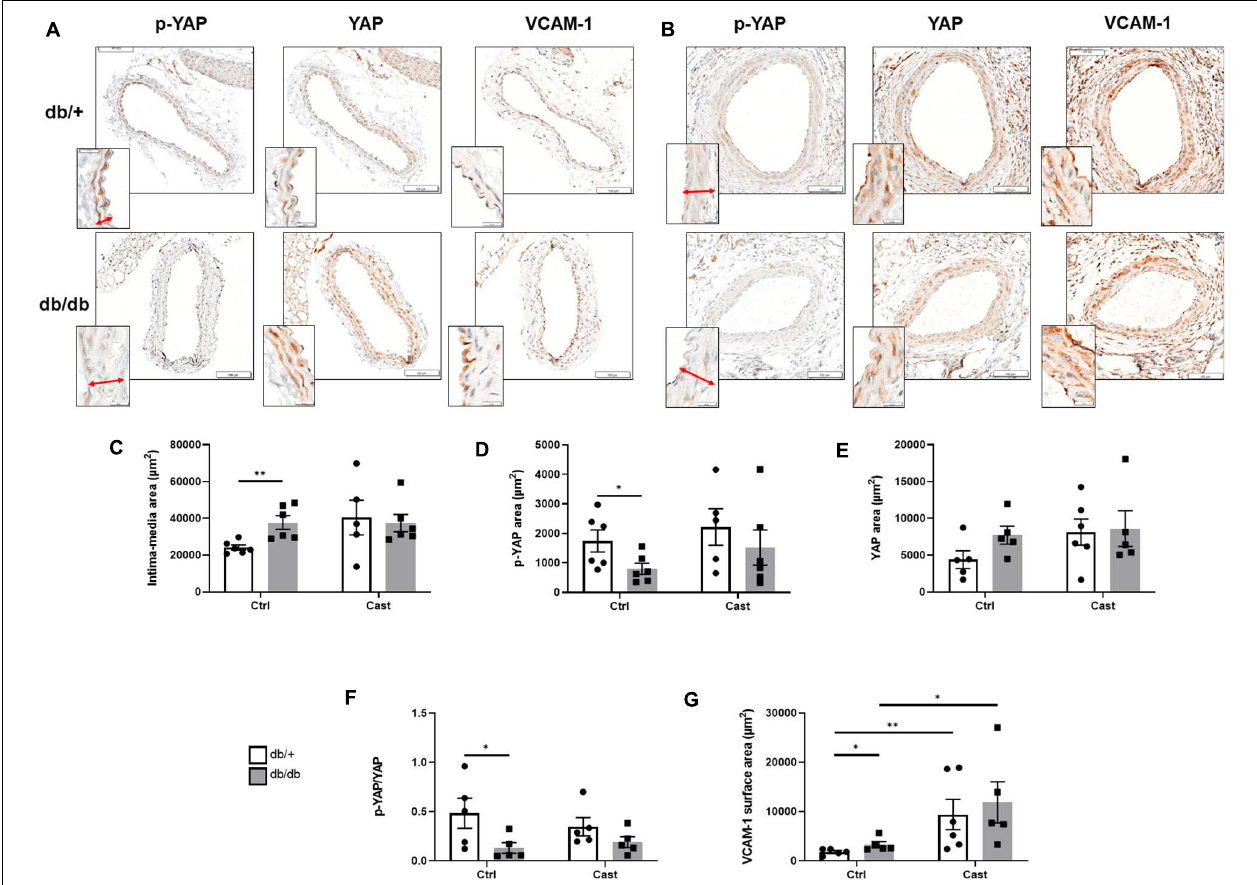
FIGURE 4 | YAP is activated in the vascular wall of diabetic mice. Representative microphotographs ( × 40 magnification) showing cross sections of either carotid arteries without cast (A) or cast-instrumented carotid arteries (B) isolated from db/ + or db/db mice and stained for p-YAP, total YAP and VCAM-1. Inserts at the lower left side show a detail of the arterial wall at higher magnification ( × 100), with the intima-media thickness indicated by an arrow. Bar graphs show the quantification of the intima-media area (C) , and the expression of p-YAP (D) , total YAP (E) , the ratio p-YAP/YAP (F) and VCAM-1 (G) . Data are presented as the mean ± SEM. N = 5–6/group. ∗ p < 0.05, ∗∗ p < 0.01 between the indicated groups. Kruskal-Wallis test was used for